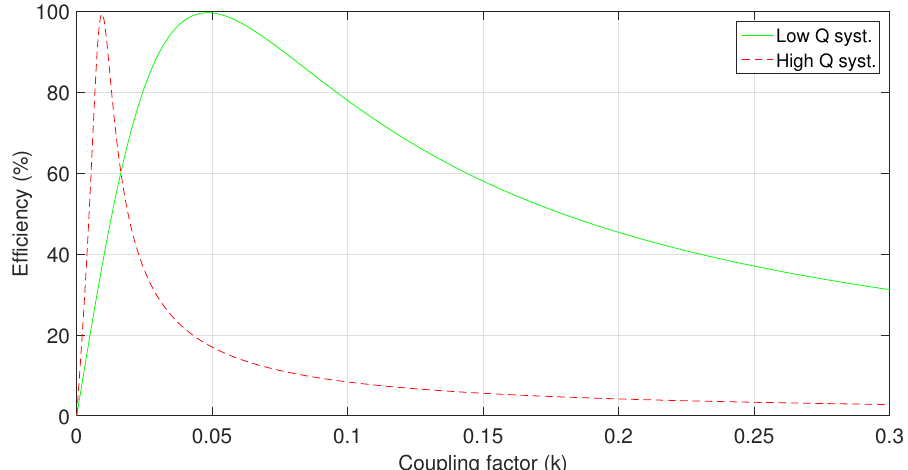
Figure 6. Comparison between the coupling factor needed for the maximum efficiency to appear for the system with low Q and high Q of the